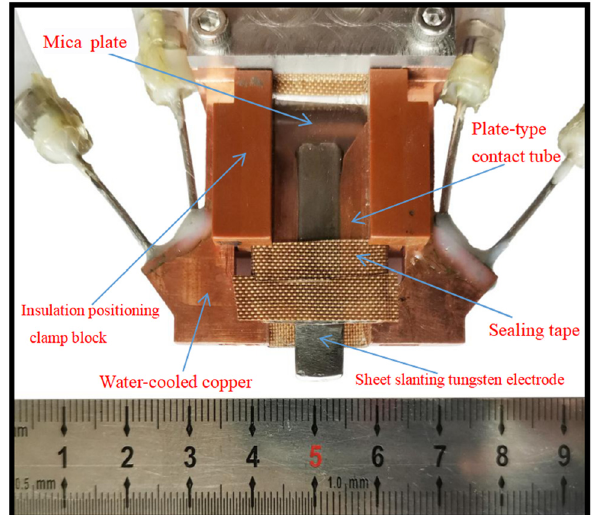
Figure 3: Schematic of principle for di ff erential analysis: ( a ) t k time electrostatic probe and ( b ) and t k + 1 time electrostatic probe. Figure 4: Welding torch